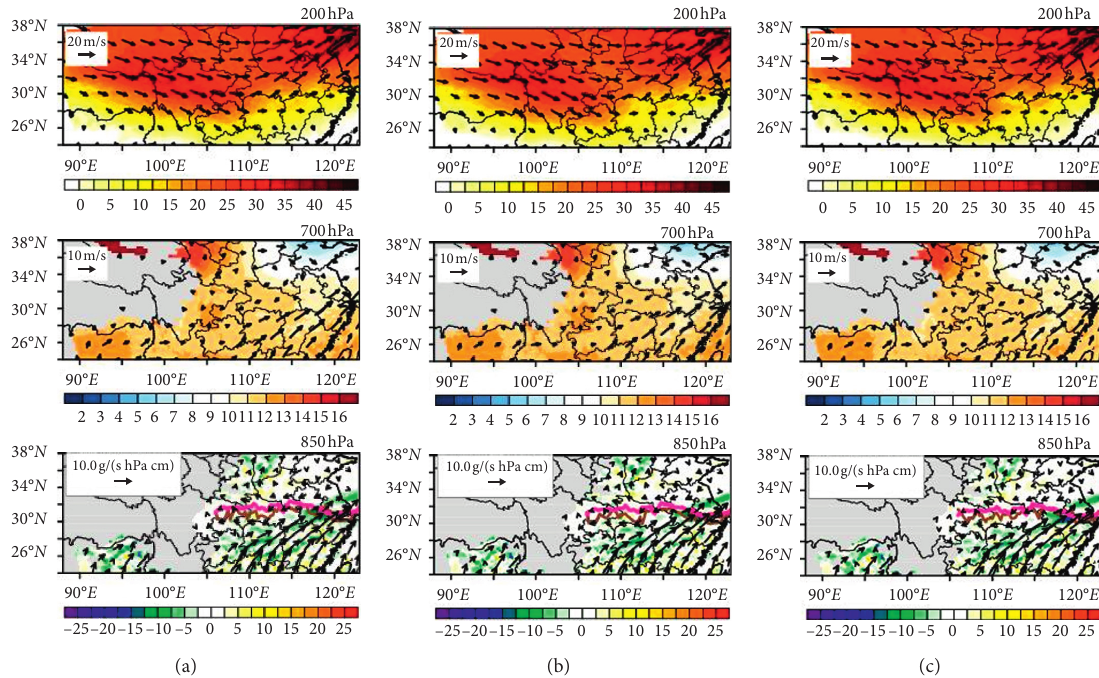
Figure 3: The same as Figure 1 except for the model output with the composite location of the Meiyu front in each experiment (observations) being indicated by a solid brown (purple)